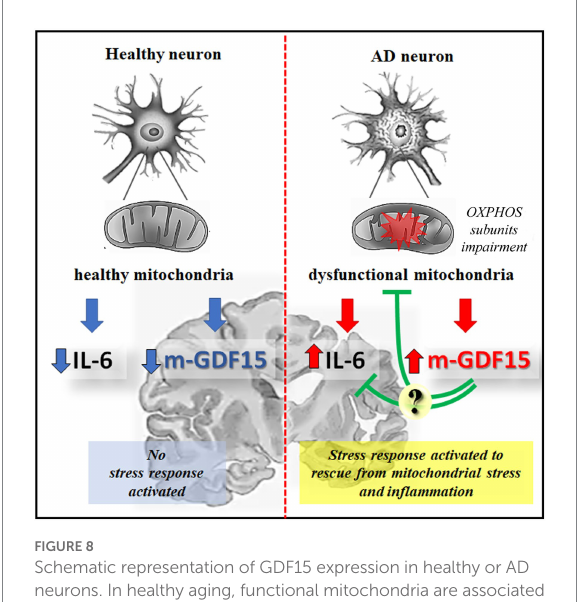
FIGURE 8 Schematic representation of GDF15 expression in healthy or AD neurons. In healthy aging, functional mitochondria are associated with a low level of inflammatory cytokines, such as IL-6, and of the mature form of GDF15 (m-GDF15), and no stress response is activated; in AD neurons an impairment of OXPHOS subunits expression is associated to mitochondrial dysfunction leading to a stress response that is associated to an increase of IL-6 and m-GDF15 protein expression. The elevated level of m-GDF15 in AD brains could be interpreted as a part of a stress response aimed at counteracting inflammation and mitochondrial